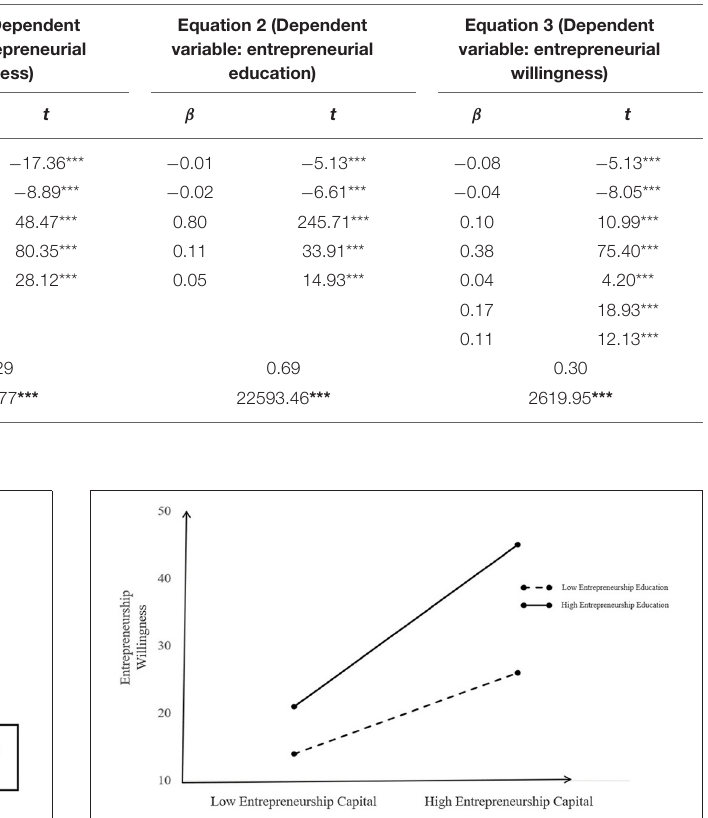
TABLE 2 | Regulated intermediary model test.